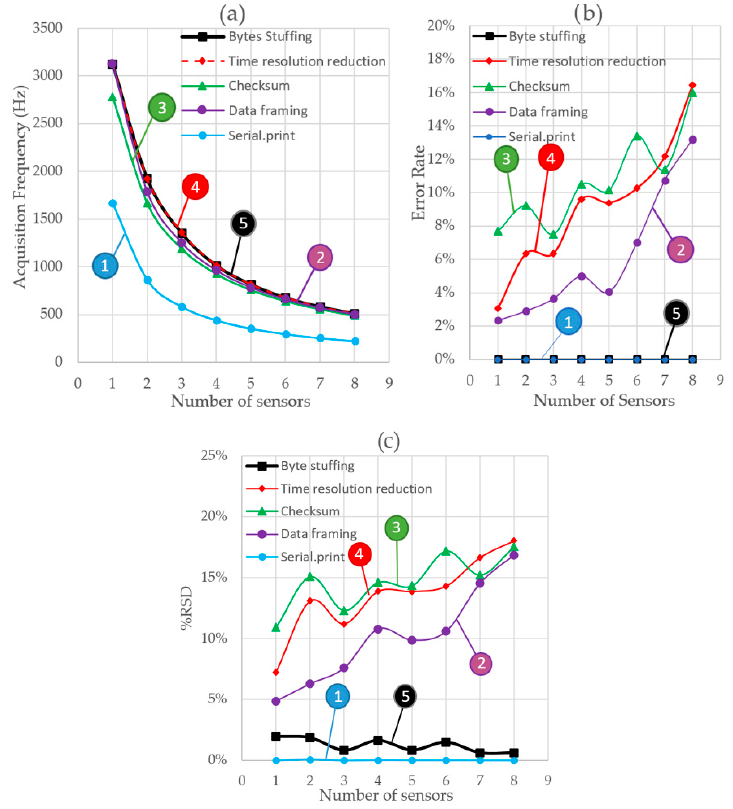
Figure 12. ( a ) Variation of acquisition frequency according to the method used, ( b ) variation of data transmission errors according to the method used, and ( c ) RSD of the acquisition frequency by method used.